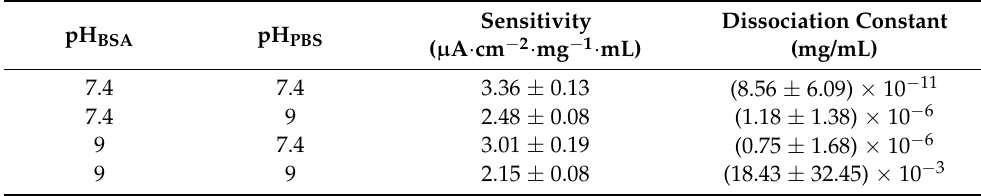
Figure 7. Variations of the current densities Δ J MIP versus cumulative BSA concentration for pH BSA and pH PBS superior to the BSA isoelectric point. The solid lines correspond to the best fits according to Equation (2). Inset: semilogarithmic scale view showing the quasilinear shape of the calibration curves for BSA concentrations varying from 10 − 15 to 10 − 3 mg/mL. Table 2. Sensitivity and dissociation constants values.